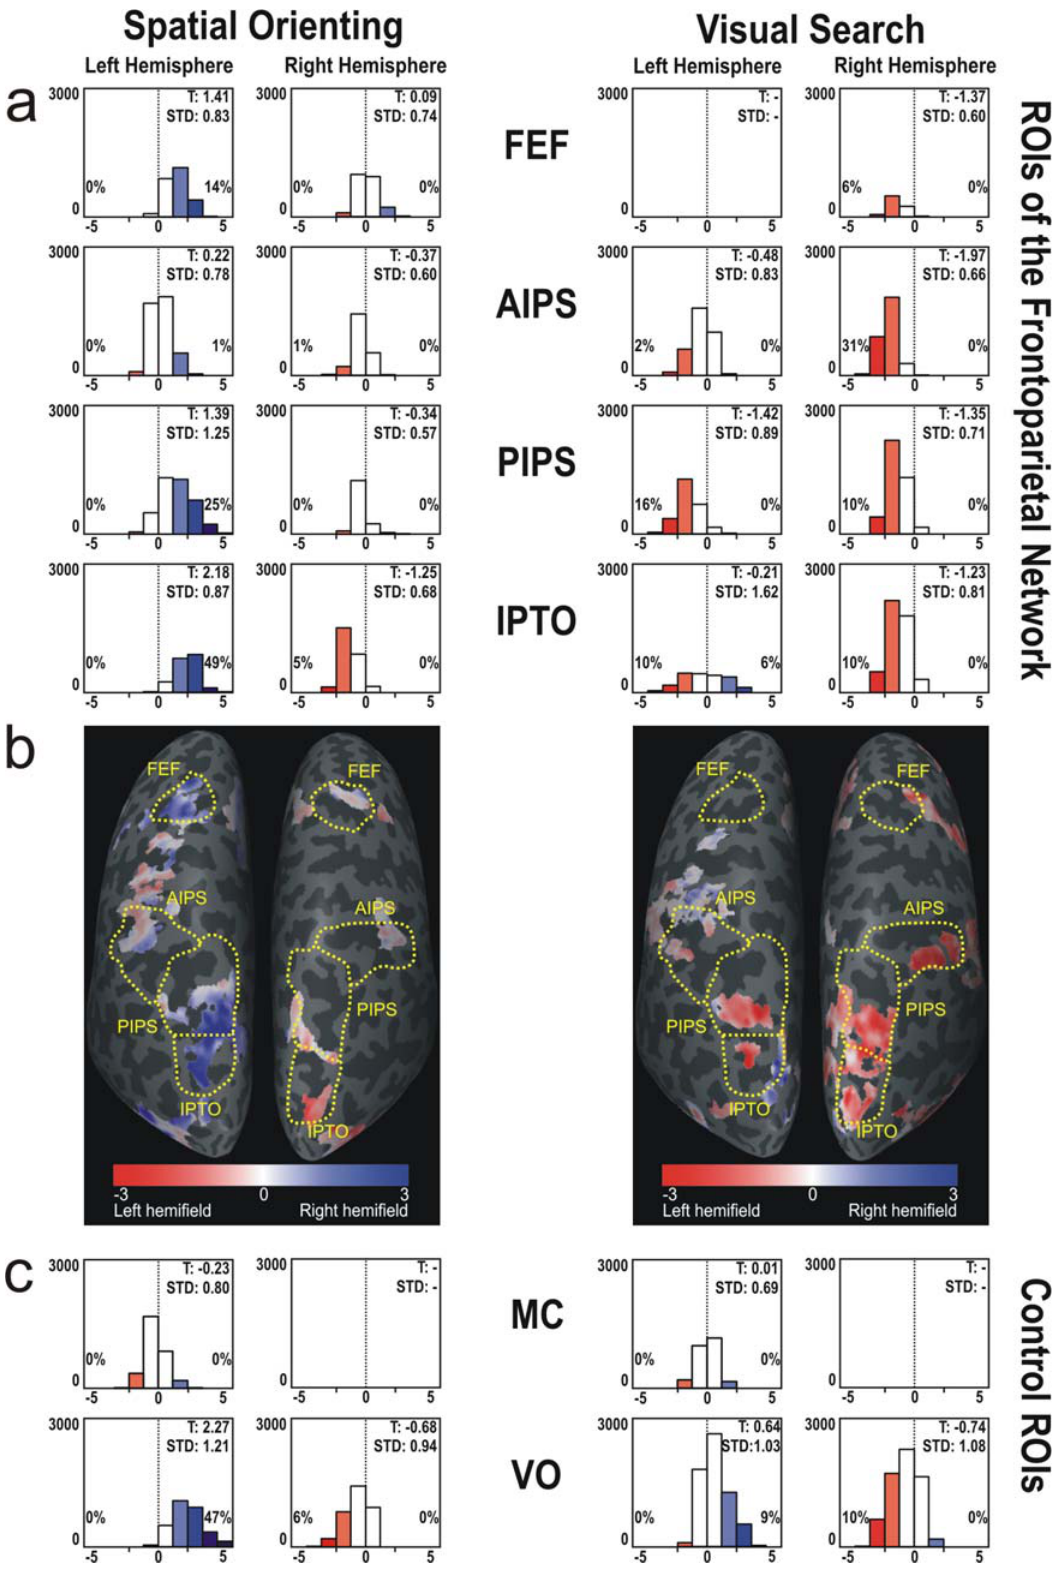
Figure 2. Contralateral preference of activated voxels during spatial orienting (SO) and visual search (VS). Contralateral preference visualized by t-tests for all voxels activated by SO and VS (p , 0.005, RFX, cluster threshold: 50 mm 2 ). Negative (red) and positive (blue) t-values indicate a preference for the left and right hemifield, respectively. Voxels with t-values ,2 2.26 or . 2.26 show a significant contralateral preference (p , 0.05) and are indicated by dark blue or red, respectively. White color indicates voxels involved in the process with no preference for either